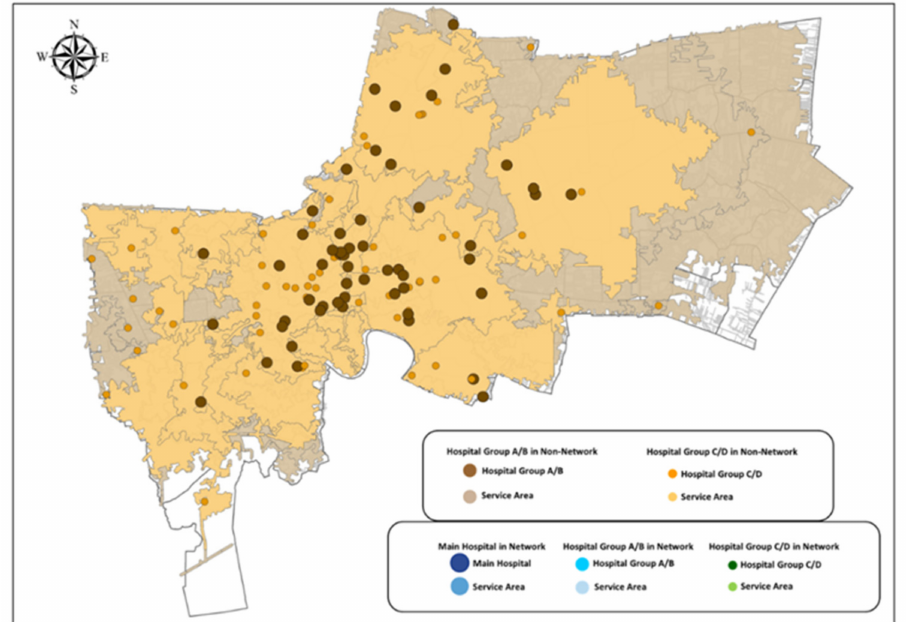
Figure 10. Service area of non-network hospitals in Group